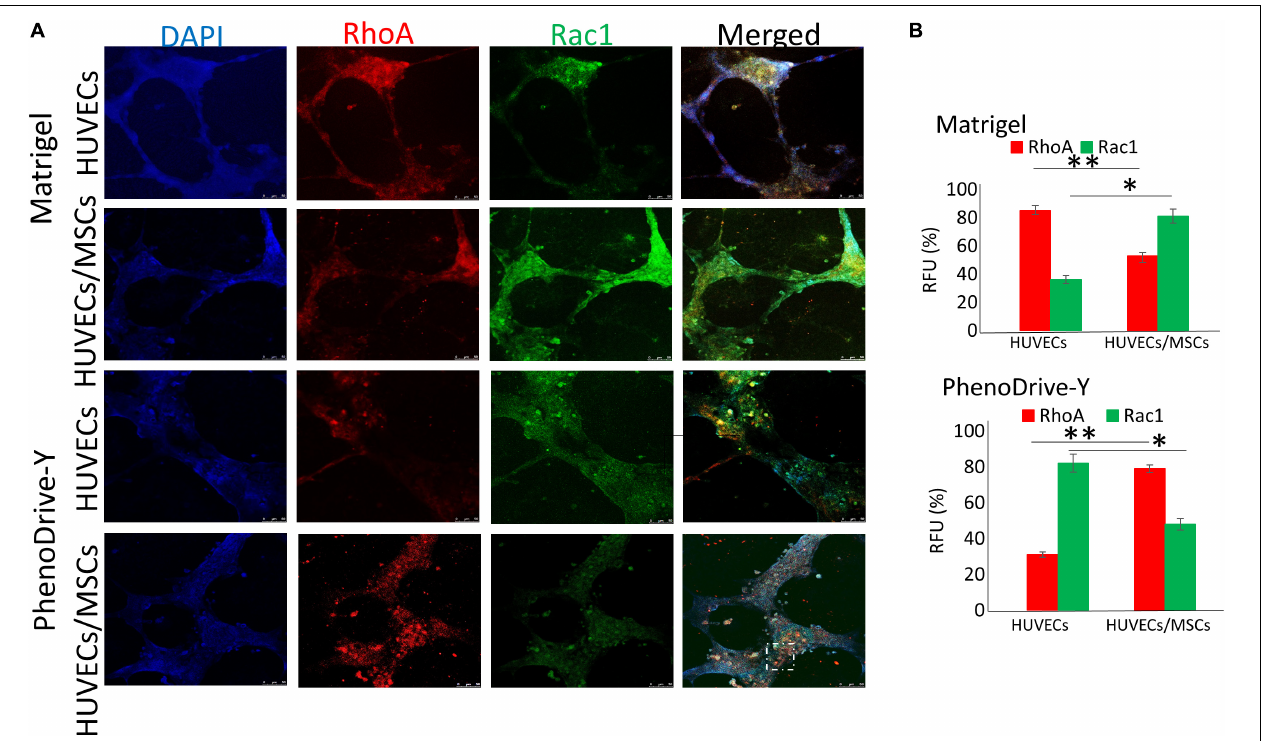
FIGURE 5 | Regulation of RhoA and Rac1 within human umbilical vascular endothelial cells (HUVECs) and HUVECs/mesenchymal stromal cells (MSCs), forming tubules on Matrigel and PhenoDrive-Y after 48 h incubation. (A) Staining of RhoA ( red ) and Rac1 ( green ) and cellular nuclei ( blue ). Dashed circle represents clusters of cells distributed around the tubules. Scale bar , 50 µ m. (B) Percentage of average fluorescence intensity (RFU) calculated using Fiji ImageJ software. ∗ p ≤ 0.01, ∗∗ p ≤ 0.001 ( ± SD; n =